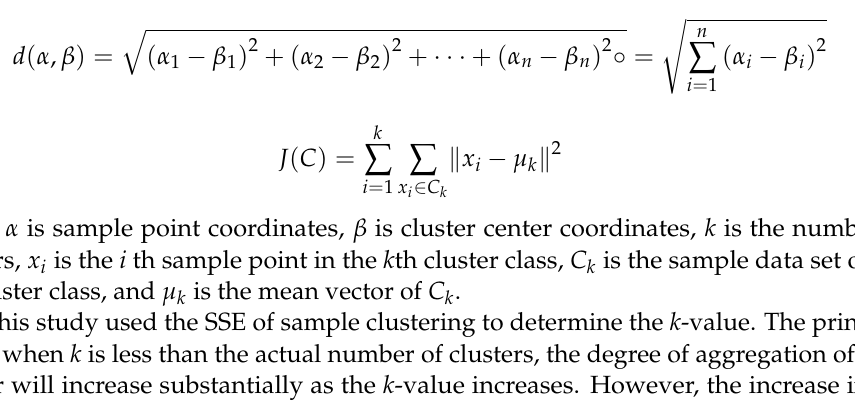
Figure 5. The number of clusters, using the SSE index.